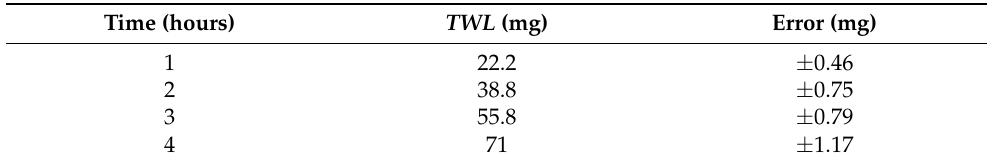
Figure 4. Change of 𝑇𝑊𝐿 with respect to time at 20 m/s and 600 mg/L . Table 1. TWL with respect to time at 20 m/s and 600